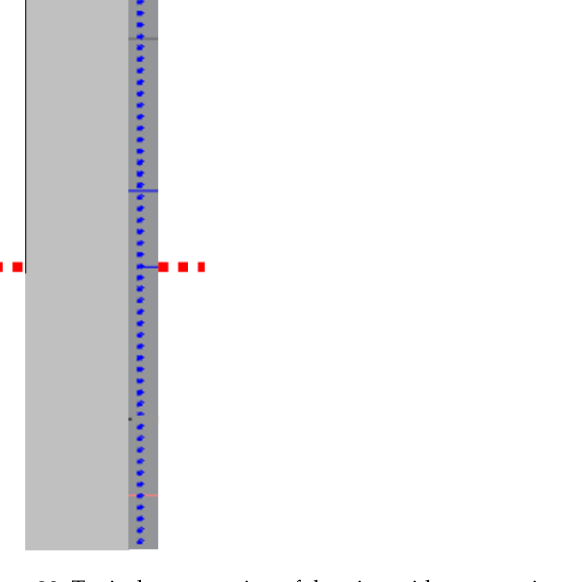
Figure 21. External façade of the pipe at the East cross ‐ section before the 3EB test.